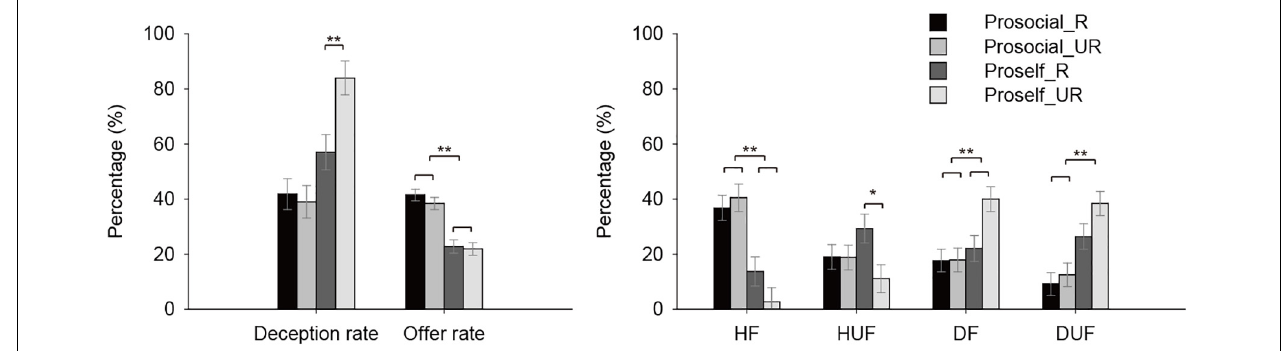
FIGURE 2 | Mean deception rate and offer rate(left), and HF, HUF, DF, and DUF rate of prosocials and proselfs when participants’ true totals would be revealed (R) or not (UR) (right) in Experiment 1. Error bar represents standard errors of the mean ( ∗∗ p < 0.01, ∗ p < 0.05).